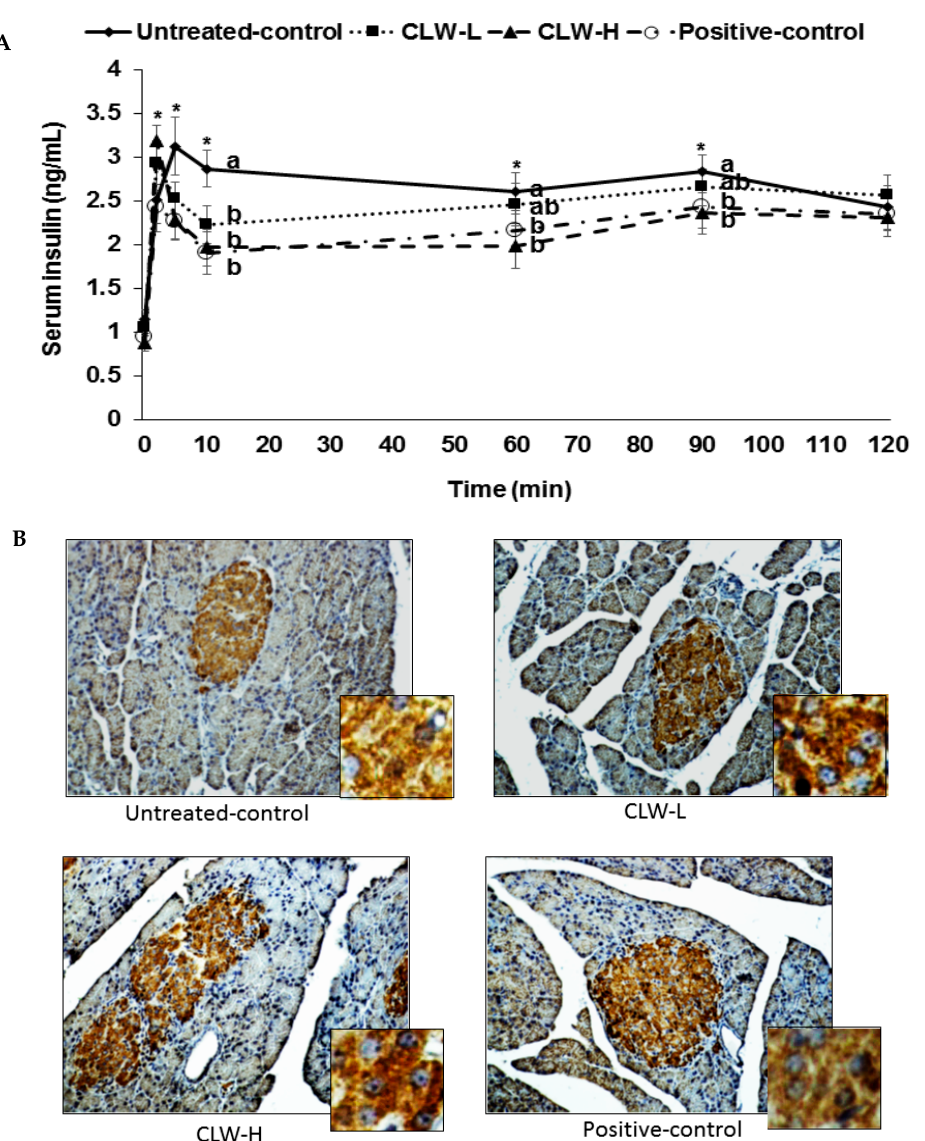
Figure 3. Glucose-stimulated insulin secretion during hyperglycemic clamp. Px rats fed a high-fat diet supplemented with 0.3% lyophilized water extract of C. lanceolata + 0.7% cellulose (CLW-L), 1% lyophilized water extract of C. lanceolata (CLW-H), 1% cellulose (untreated control), or rosiglitazone (20 mg/kg body weight/day) + 1% cellulose (positive control). At the 8th week serum insulin levels were determined at 0, 2, 5, 10, 60, 90, and 120 min to make serum glucose levels above 5.5 mM from the baseline by infusing glucose solution into the jugular vein ( A ); The insulin-positive-staining (brown) and nucleus (blue) were measured by the pancreas using immunohistochemistry ( B ). The big and small pictures in each group were ×40 and ×400 magnification, respectively. Dots and error bars represent means ± standard deviation ( n = 8). * Significantly different among the groups in one-way analysis of variance at p < 0.05. a,b Means of the bars without a common letter significantly differ at p < 0.05 by Tukey test.